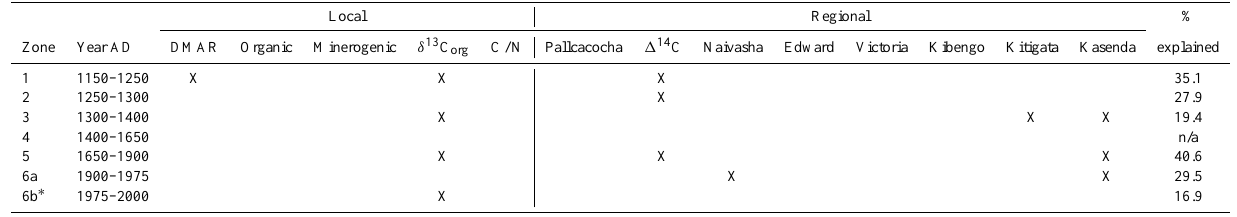
Table 3. Results of the moving window RDA from Lake Nyamogusingiri. The variance explained is a percentage of the constrained variance. The shaded boxes highlight the most statistically significant driver(s) correlated with a change in the diatom stratigraphy in each of the age groupings.